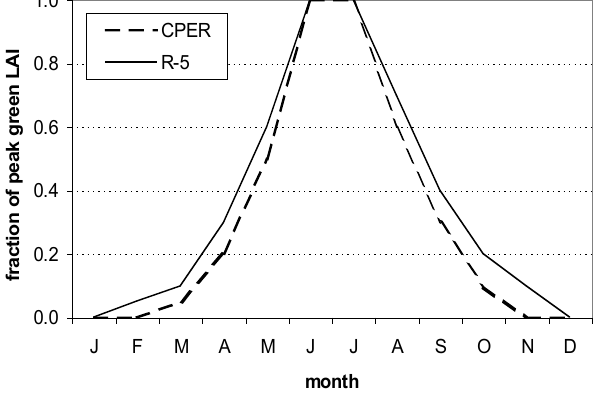
Fig. 7. Phenology of green LAI. The wider curve for the R-5 wa- tershed is reflective of a longer growing season.